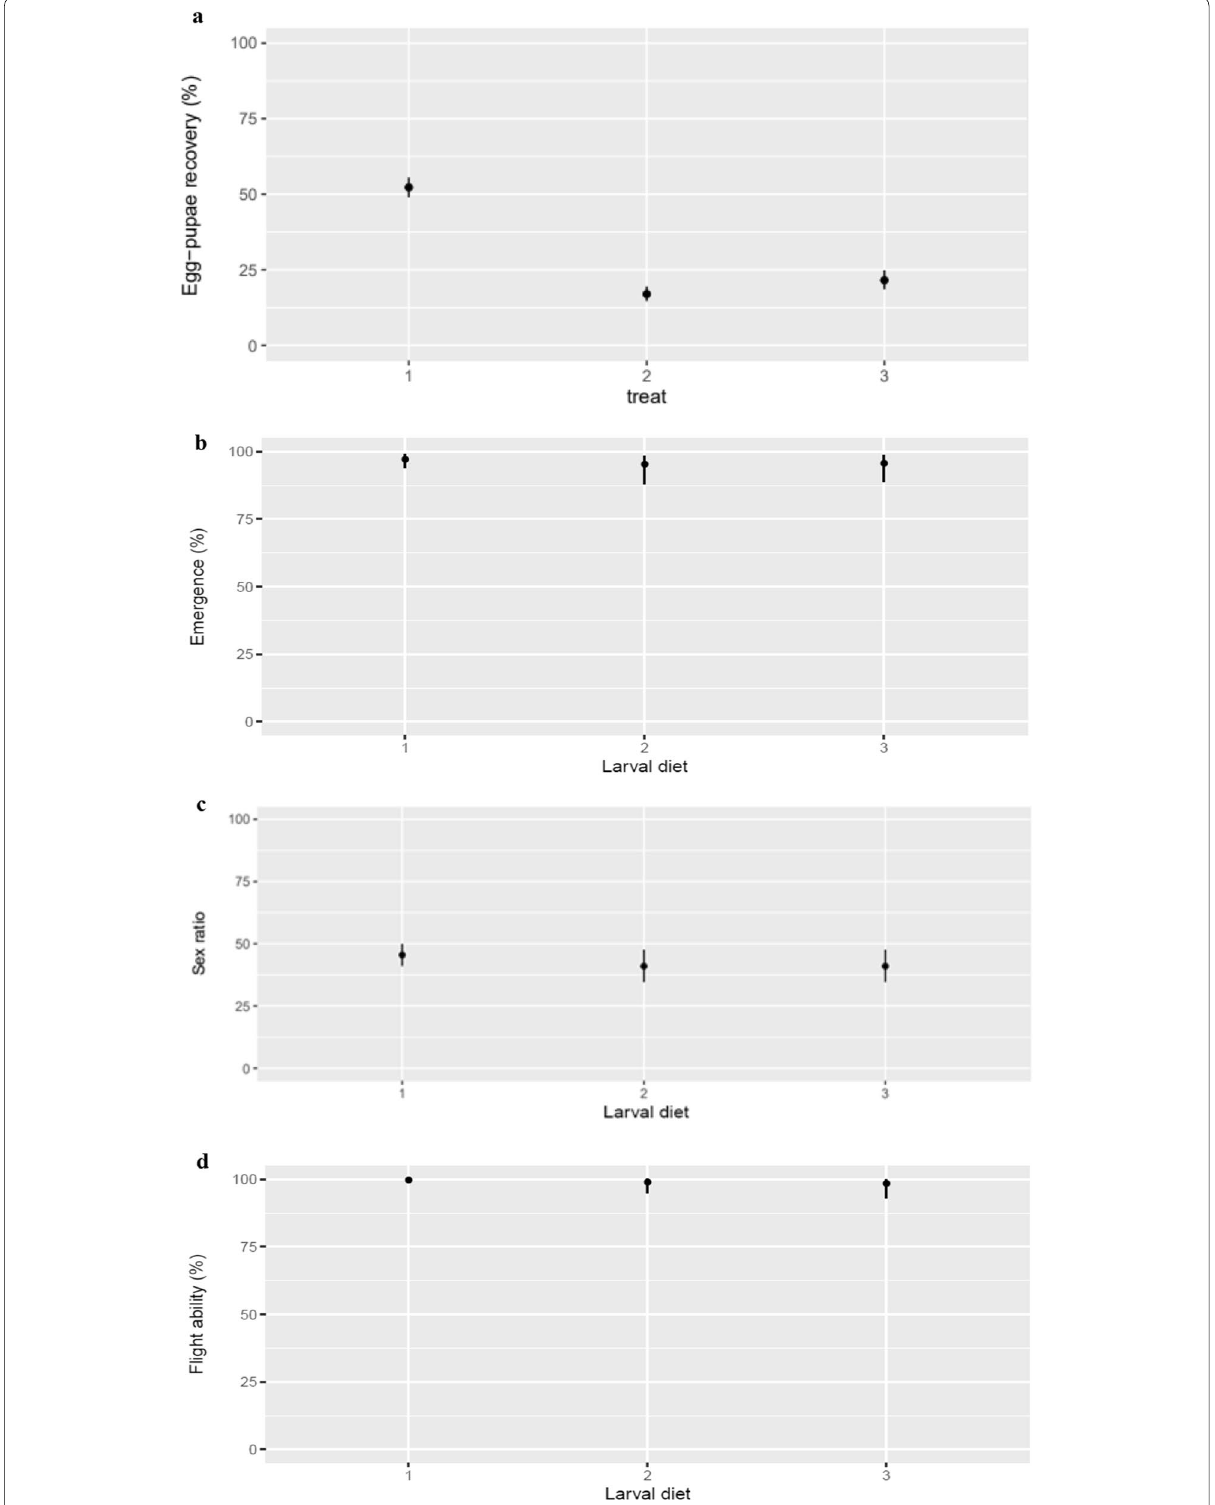
Fig. 4 Plot of fitted proportions with quasi-binomial confidence intervals. Legends for a , b , c and d 1: larval diet based on corn flour; 2: larval diet based on sugarcane bagasse; 3: larval diet based on lyophilized carrot powder. a Egg-pupae recovery (%). b Emergence (%). c Sex ratio. d Flight ability